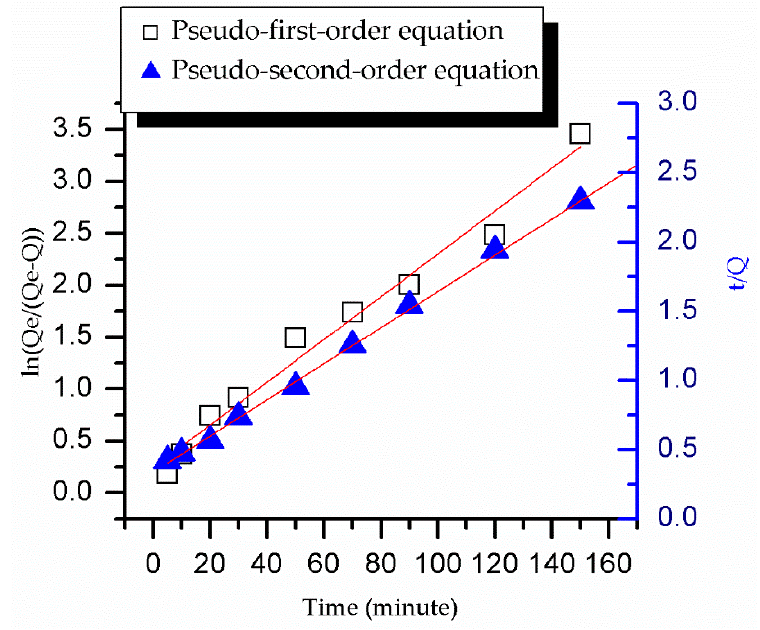
Figure 11. The pseudo-first-order and pseudo-second-order kinetic model diagrams of SSO-MIPs.